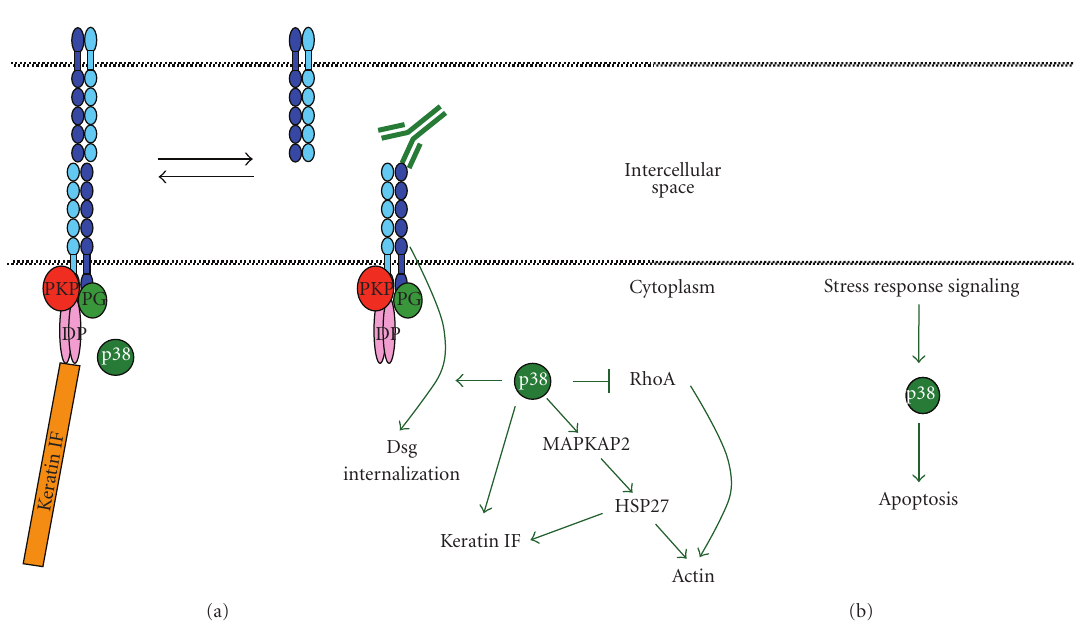
mechanistically divergent observations is not as di ffi cult as it would first